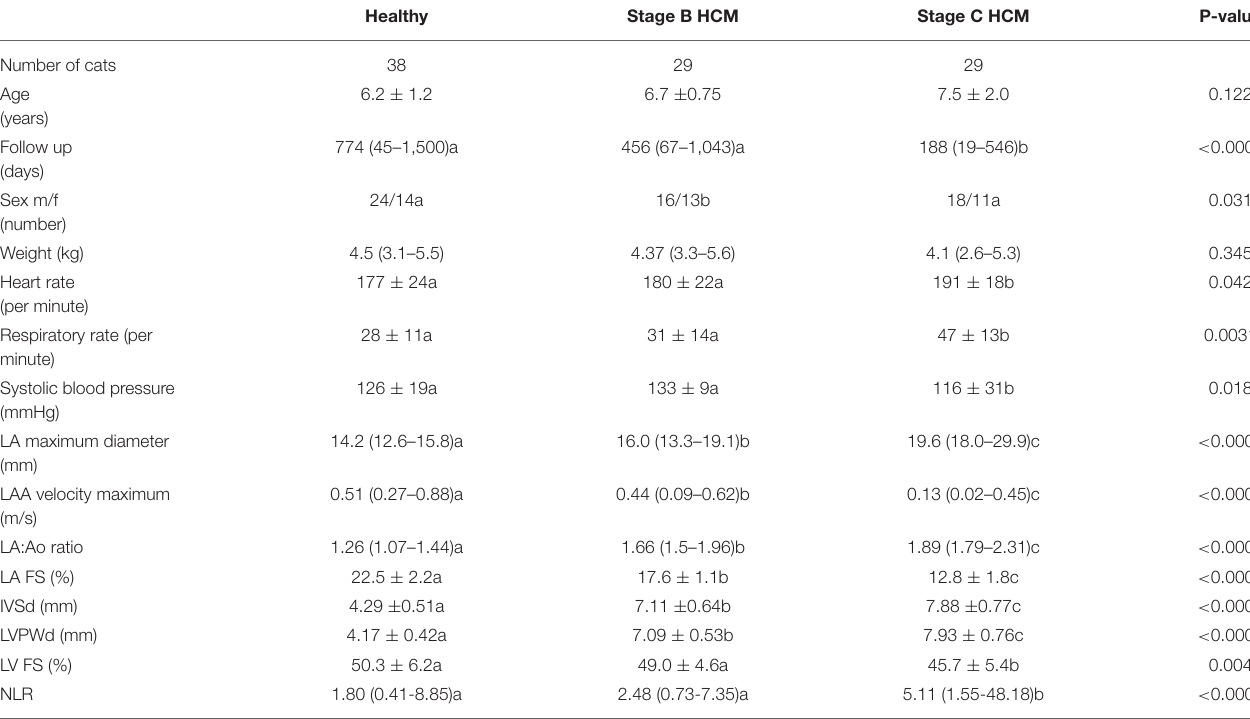
TABLE 1 | Demographic, physical examination, echocardiographic, and hematologic data in 96